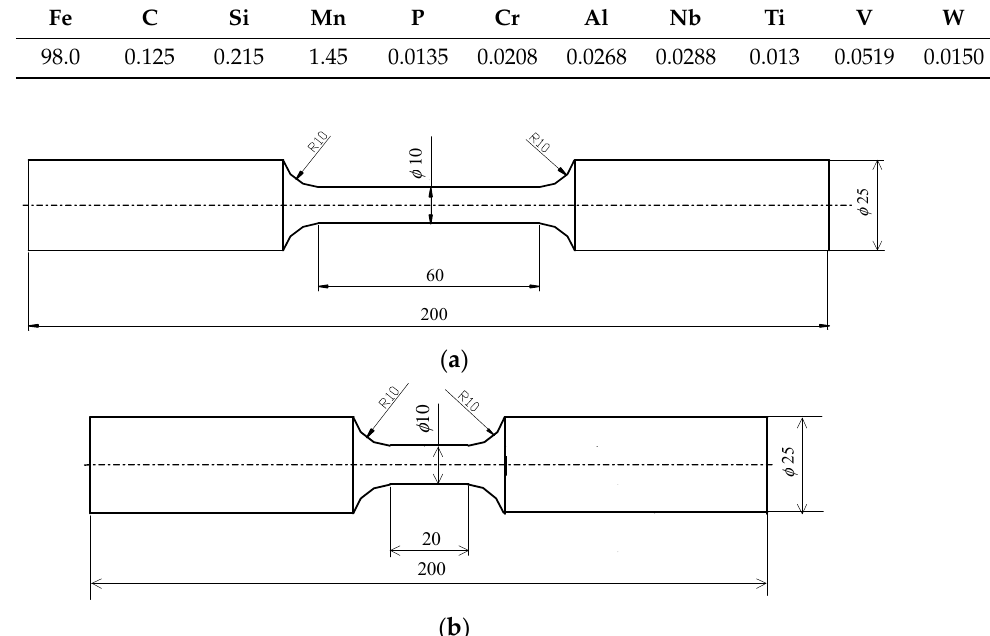
Table 1. Chemical composition of S420M steel in weight percent.